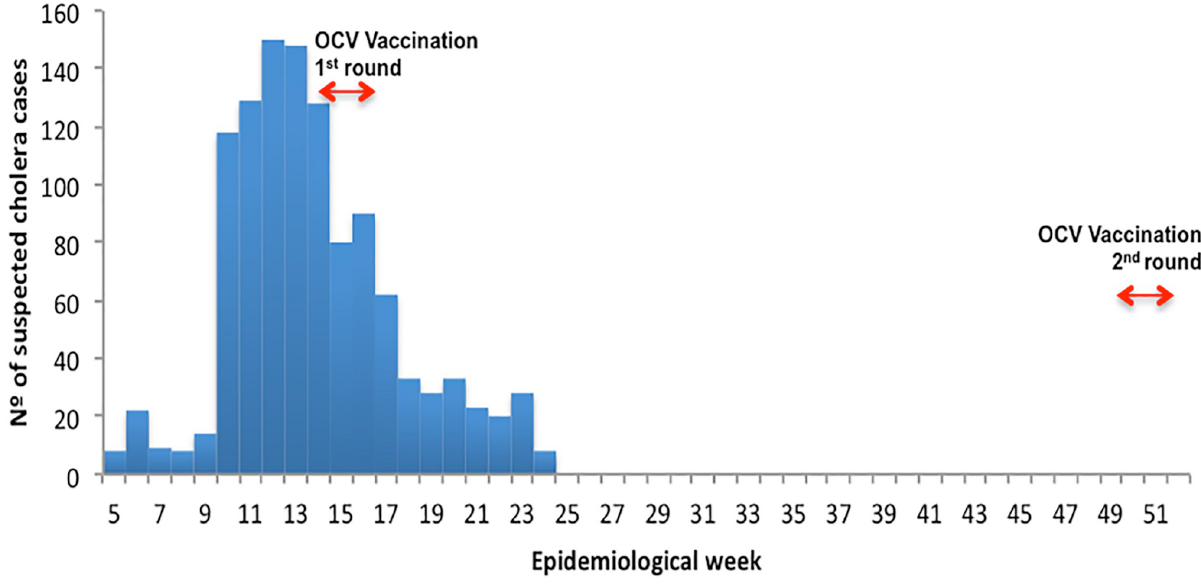
Fig 1. Cholera epidemic curve, Lusaka, Zambia,